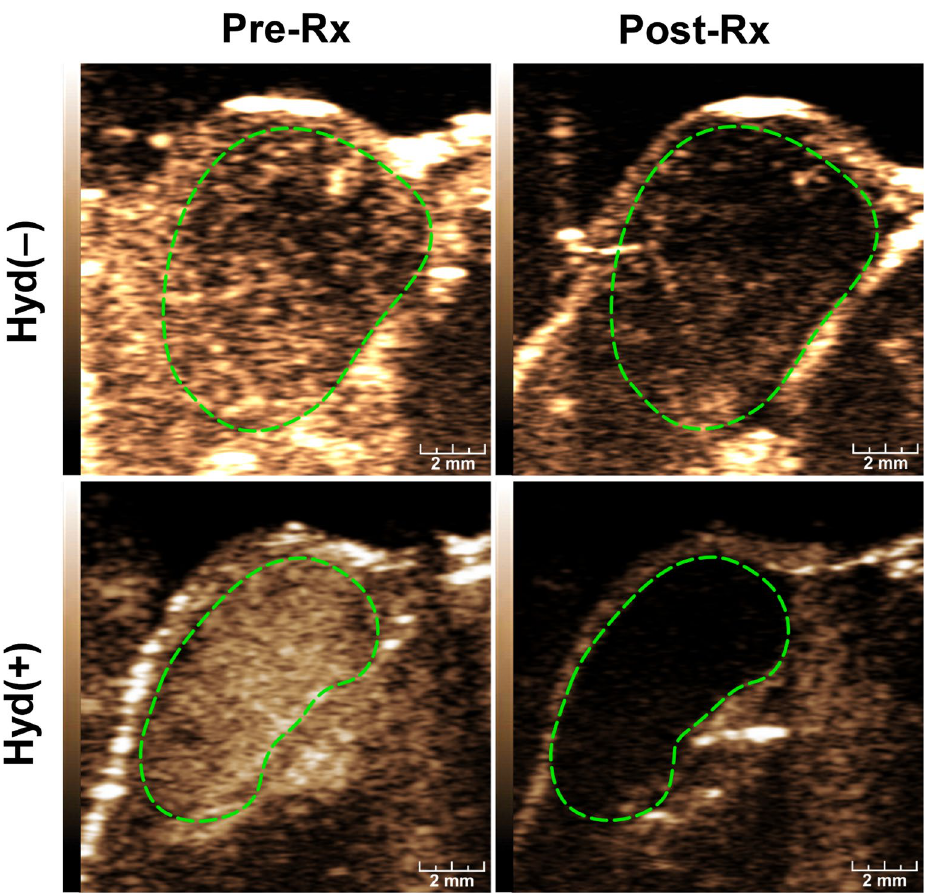
Figure 3. Effects of combined ultrasound and hydralazine treatments on HCC blood flow. Non-linear contrast- enhanced (NLC) images were acquired prior to (Pre-Rx) and following (Post-Rx) ultrasound treatment with [Hyd(+)] or without [Hyd(−)] administration of 5 mg/kg hydralazine; the margins of the tumor were outlined in dotted lines on the grayscale images (not shown) were copied to the NLC image acquired